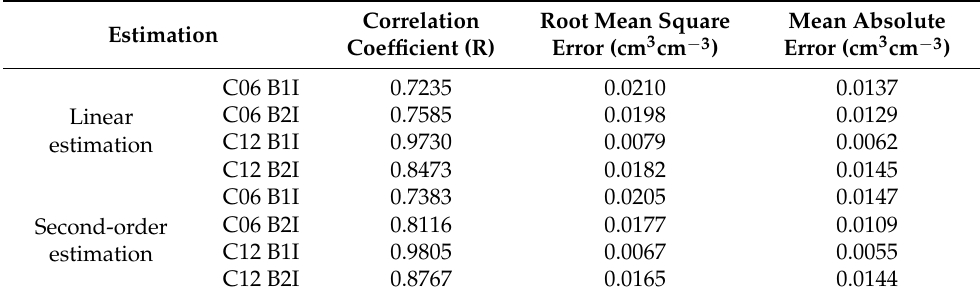
Figure 10. Correlations between single-satellite track second-order soil moisture estimations for BDS IGSO (C06) and MEO (C12) satellites on B1I and B2I frequencies. Table 2. Comparison between linear and second-order estimations.